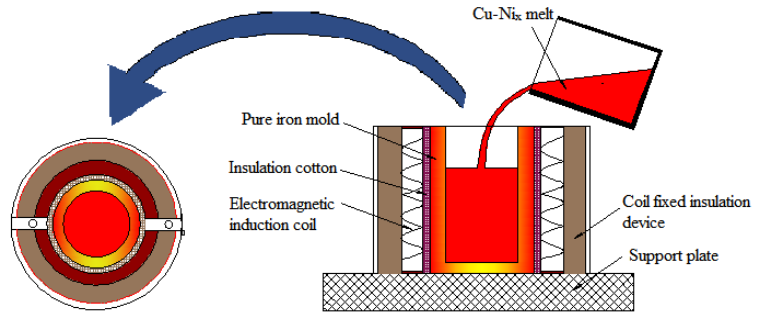
Figure 2. Schematic diagram of the casting process of Fe/Cu bimetallic materials.